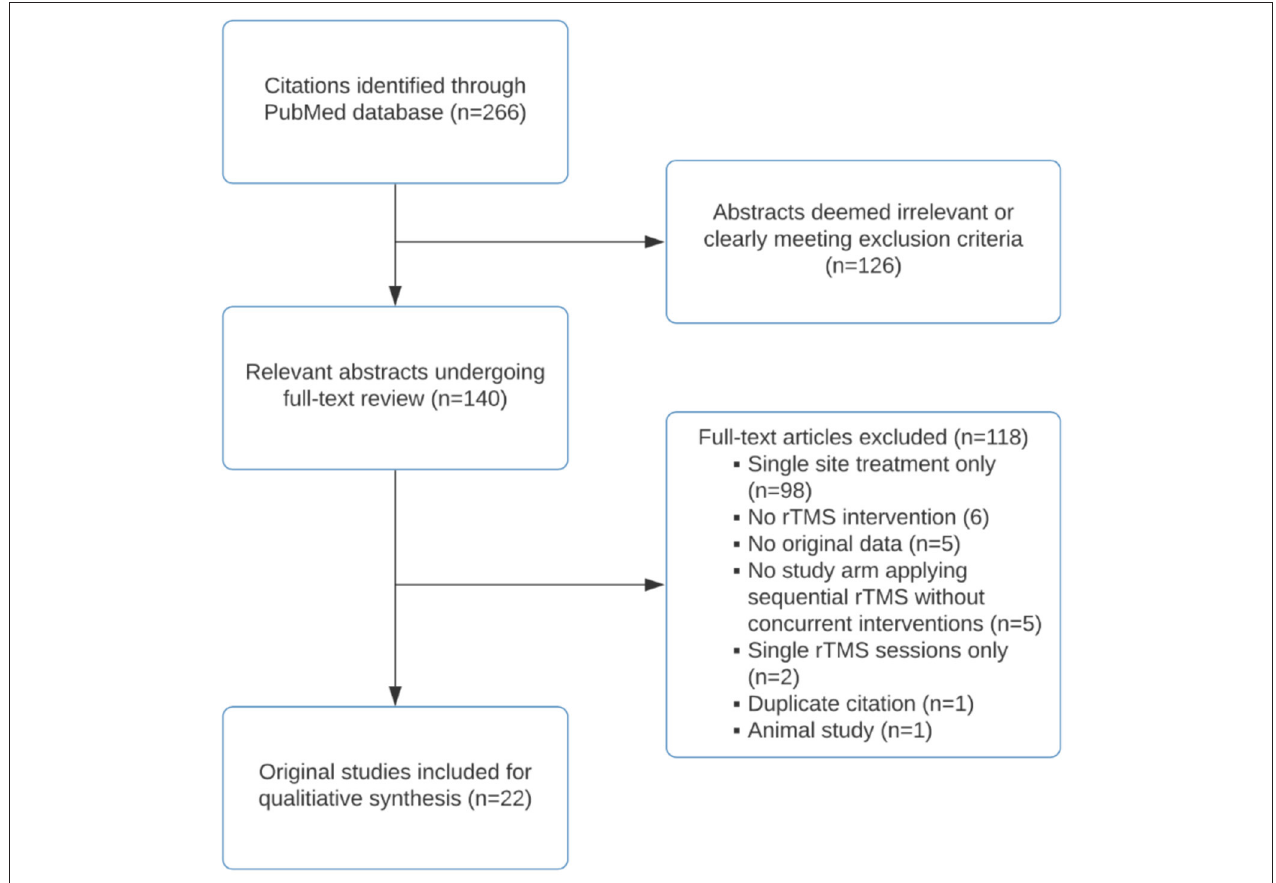
FIGURE 2 | PRISMA flow diagram of literature